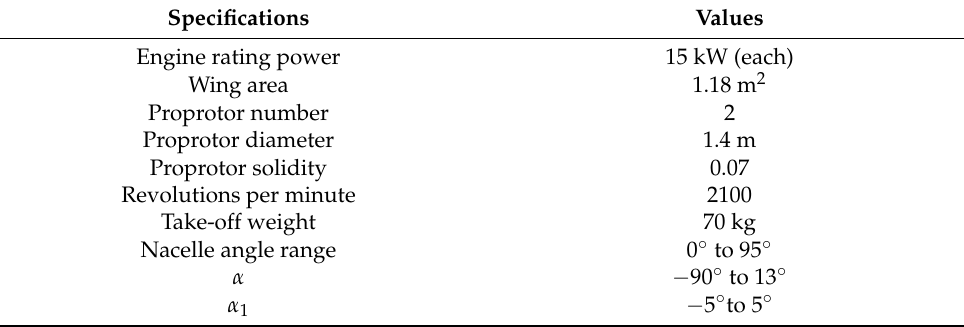
Figure 10. ( a ) Three flight modes of the rotor wing (V/STOL, conversion, and cruise) [35]; and ( b ) aerodynamic characteristics of three nacelle angles. Table 4. The salient specifications of the rotor-wing aircraft